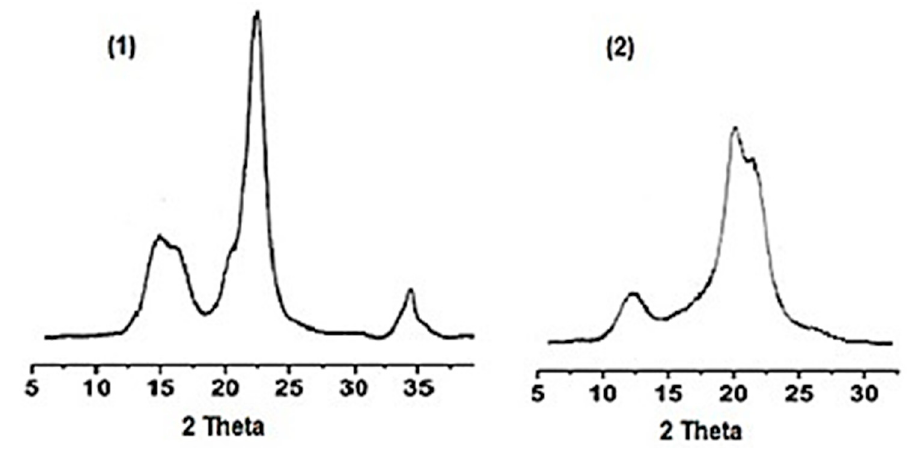
Figure 1. X-ray patterns of original ( 1 ) and mercerized ( 2 )